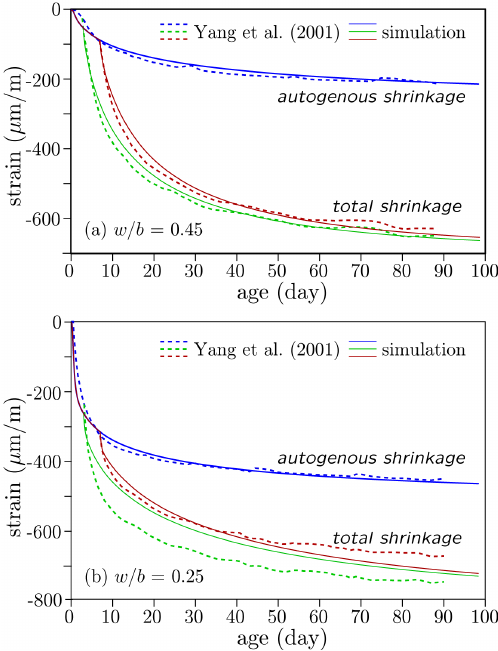
Figure 11. Autogenous and drying shrinkage